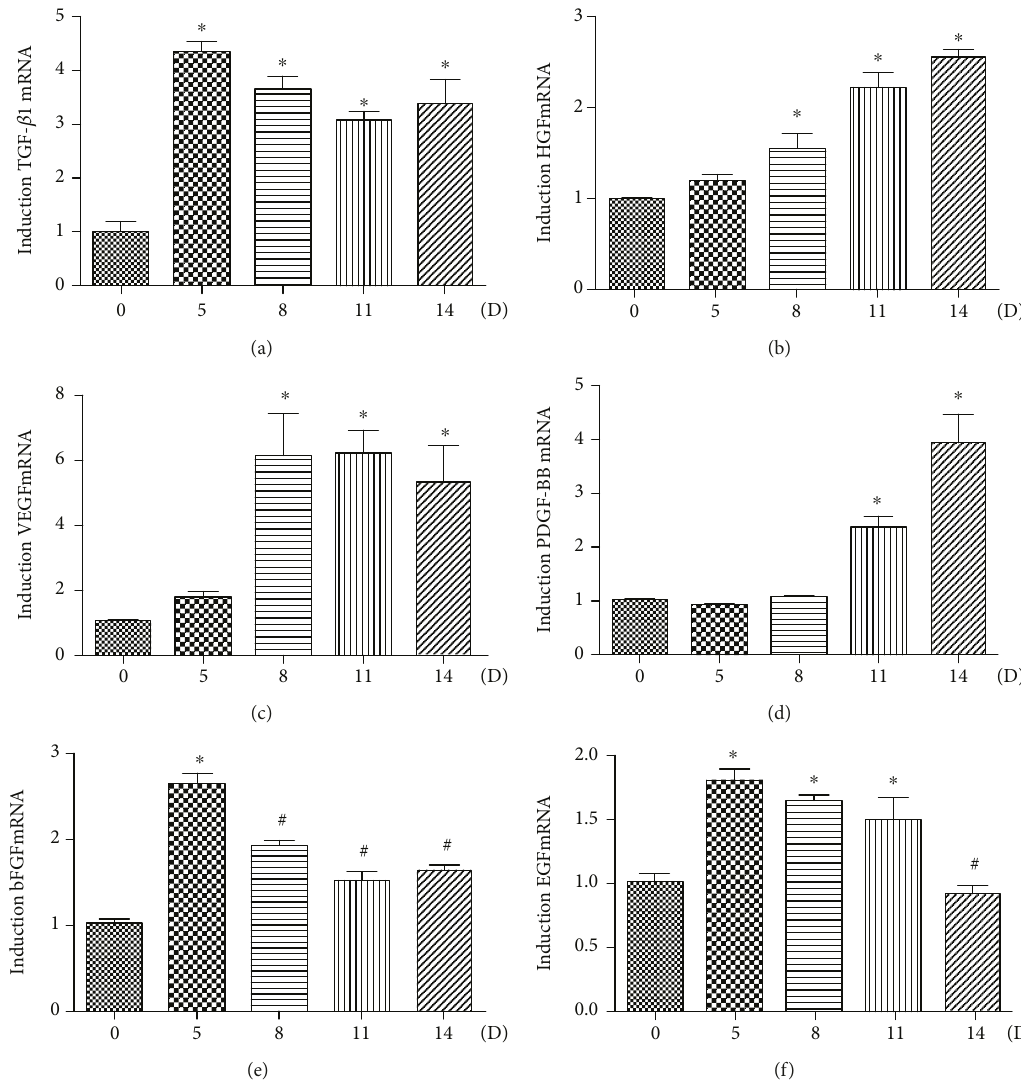
Figure 5: Growth factor analysis in SMC di ff erentiation from DPSC clone A32. The A32 clone was induced following the SMC induction protocol for the indicated time (0 d, 5 d, 8 d, 11 d, and 14 d). The mRNA expressions of TGF- β 1 (a), HGF (b), VEGF (c), PDGF-BB (d), bFGF (e), and EGF (f) were analysed with qPCR. Statistical analysis was performed by using one-way ANOVA. Date are shown as means ± SEM . ∗ P < 0 05 when compared with the 0d